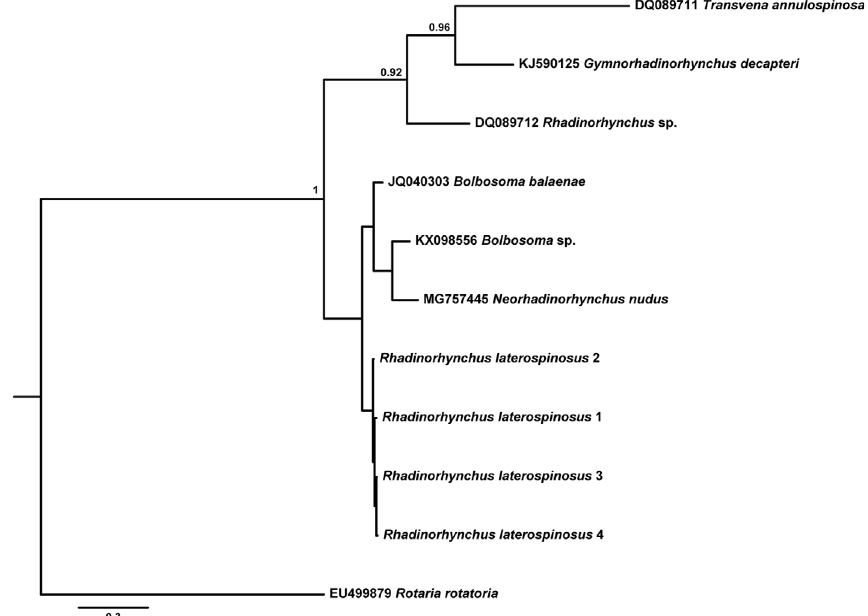
Figure 39. Bayesian inference (BI) phylogram reconstructed using four newly generated cox 1 sequences for Rhadinorhynchus laterospinosus and retrieved sequences from GenBank for Rhadinorhynchus and the closest-related sequences to members of this genus. Outgroup: Rotaria rotatoria . Posterior probability values lower than 0.95 are omitted. The scale-bar indicates the expected number of substitutions per site.